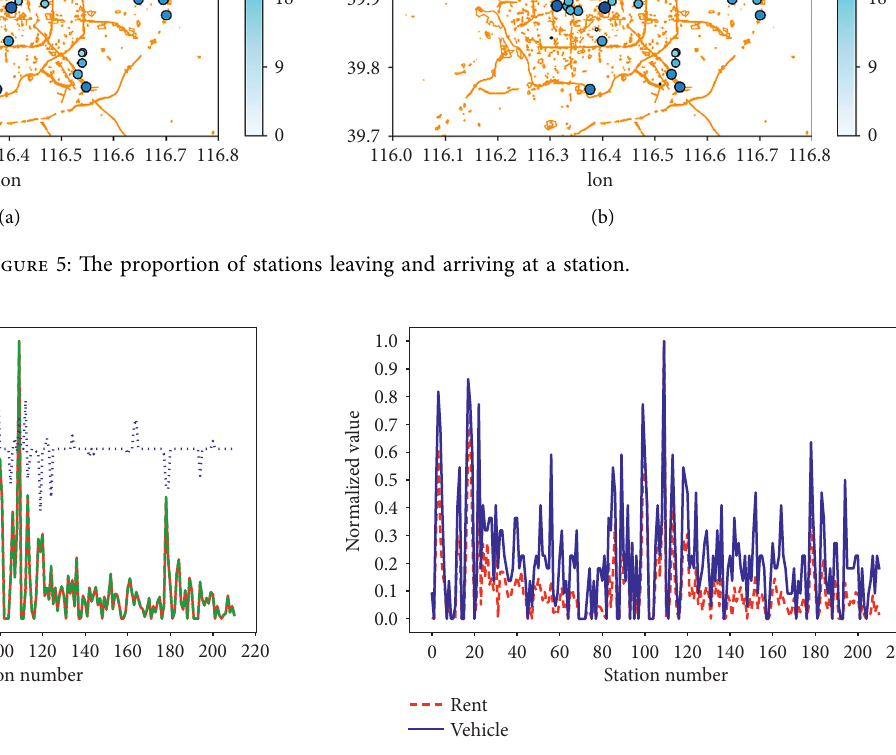
Figure 8: Rental record and initial vehicle